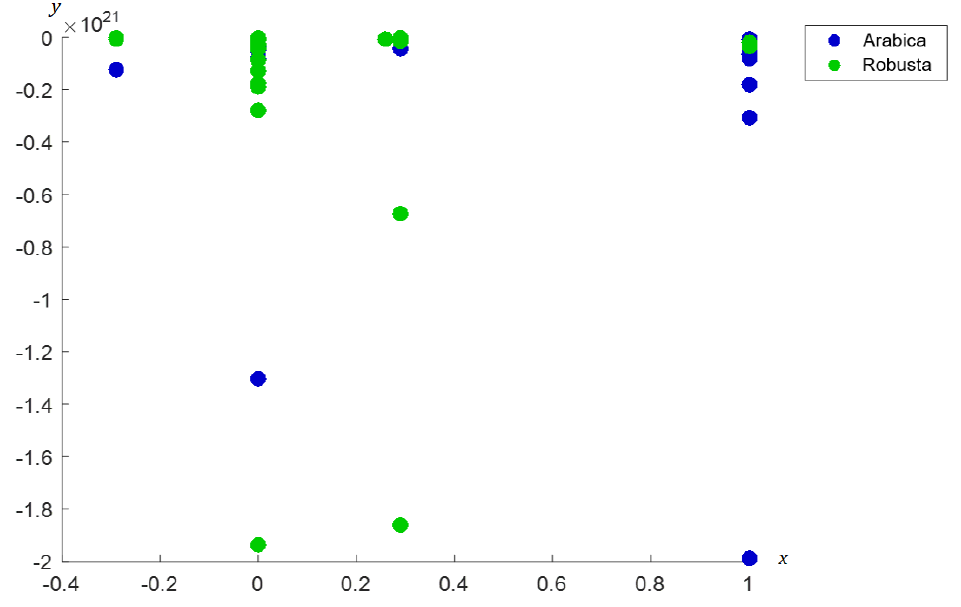
Figure 7. Coordinated FACS of Arabica and Robusta coffee beans. Mathematics 2020 , 8 , x FOR PEER REVIEW